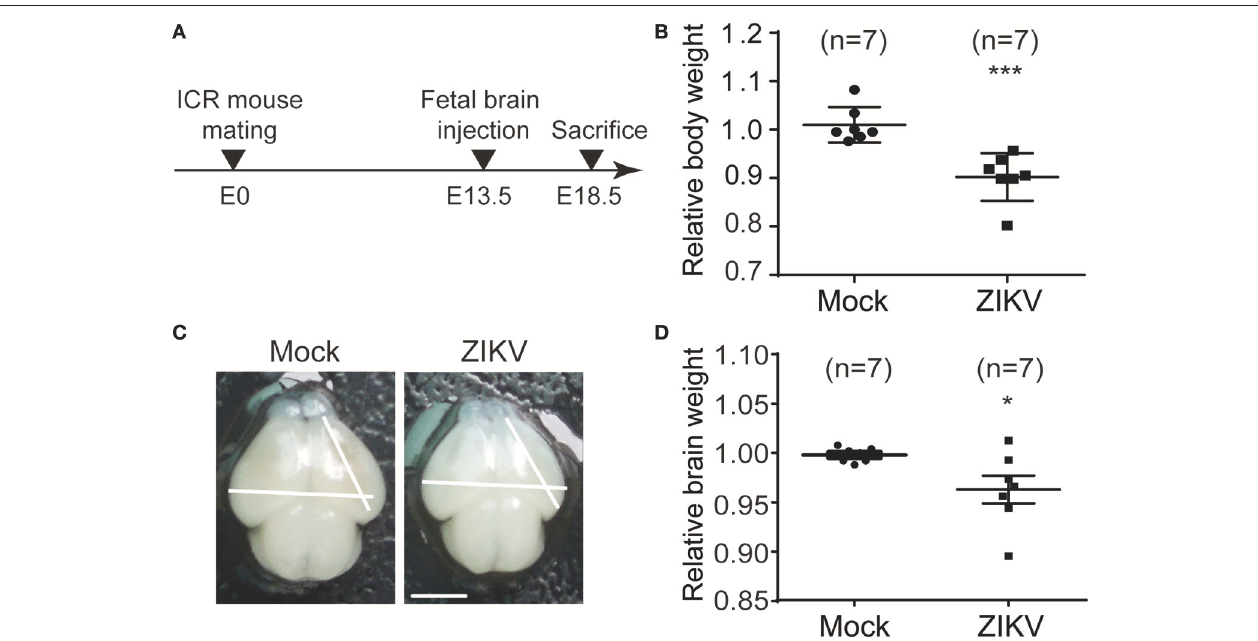
FIGURE 6 | ZIKV infection decreases the body weight, brain size and weight of mouse fetuses. (A) Schematic depiction of a ZIKV-infected fetal mouse brain model. ICR mice were mated, and pregnant mice were selected. Fetuses were intracranial injected with ZIKV (104 PFU) or mock-infected at E13.5. Mice were sacrificed at E18.5 and fetuses were harvested for measurements of body weight, brain size and weight. (B) Relative body weight. The body weights of mock- and ZIKV-infected fetuses at E18.5 were measured. Data are representative of at least 3 independent experiments with more than 1 pregnant female dam per experiment. The n for each group is indicated above each bar. *** p < 0.0001. (C) Image of brains. Fetal brains from mock- and ZIKV-infected fetal littermates at E18.5. Scale bar, 5mm. (D) Relative brain weight. Fetal brains of mock- and ZIKV-infected fetuses at E18.5 were measured. Data were collected from at least 3 independent experiments with more than 1 pregnant female dam per experiment. The n for each group is indicated above each bar. * p <